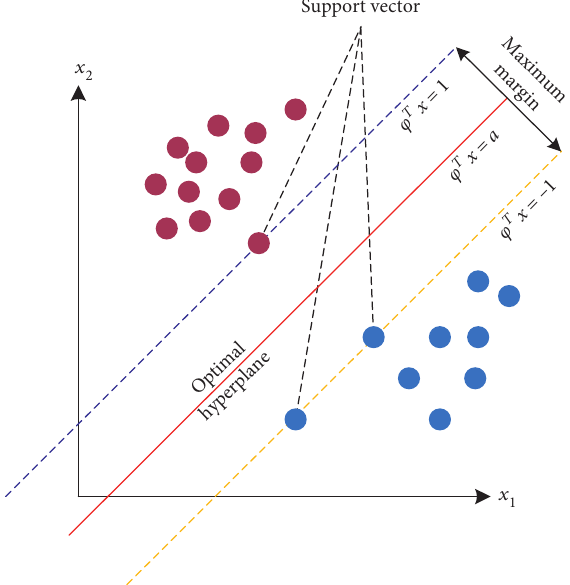
Figure 2: Schematic diagram of support vector